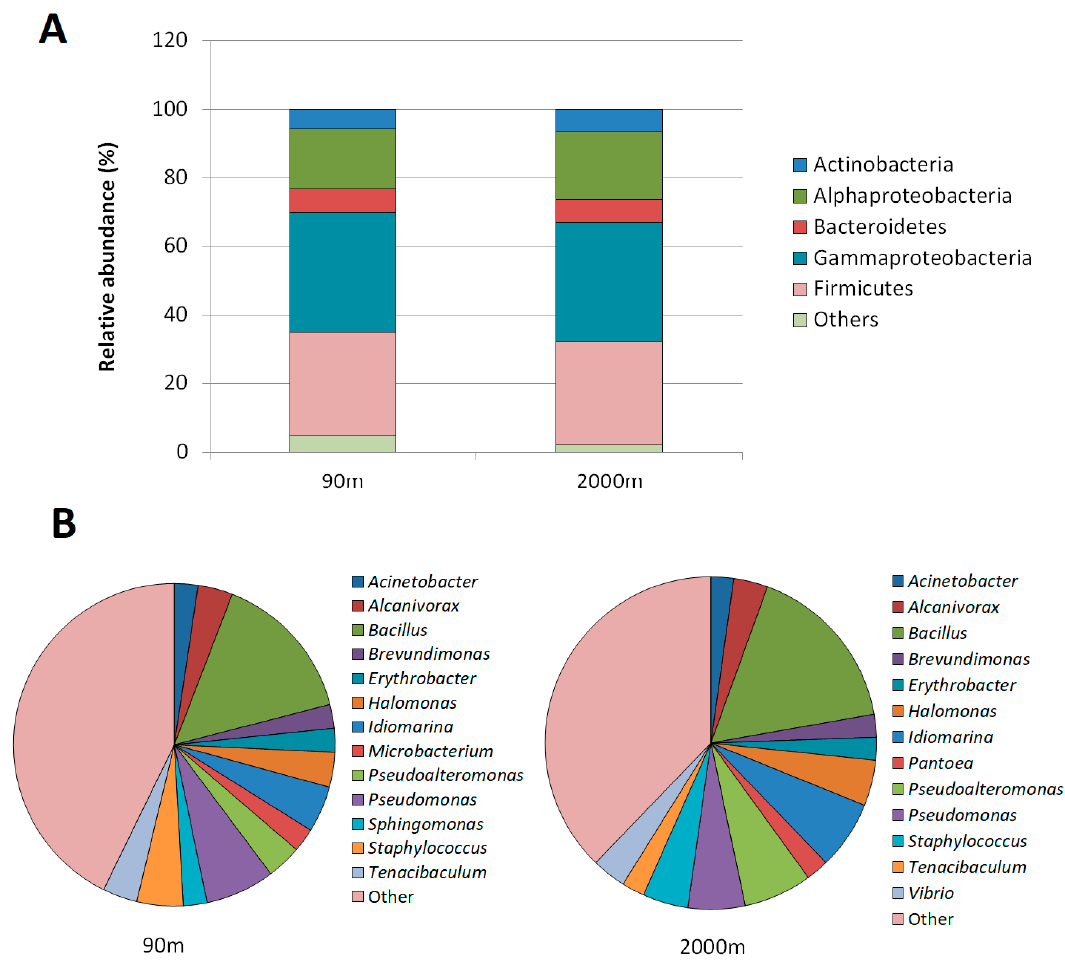
Figure 2. ( A ) Bacterial diversity in cultivable bacteria isolated from photic (90 m depth, n = 231) and aphotic (2000 m depth, n = 374) samples; ( B ) relative abundance of the 13 most abundant genera in 90 and 2000 m depth samples. The genera represented by a single isolate are grouped as “other”.